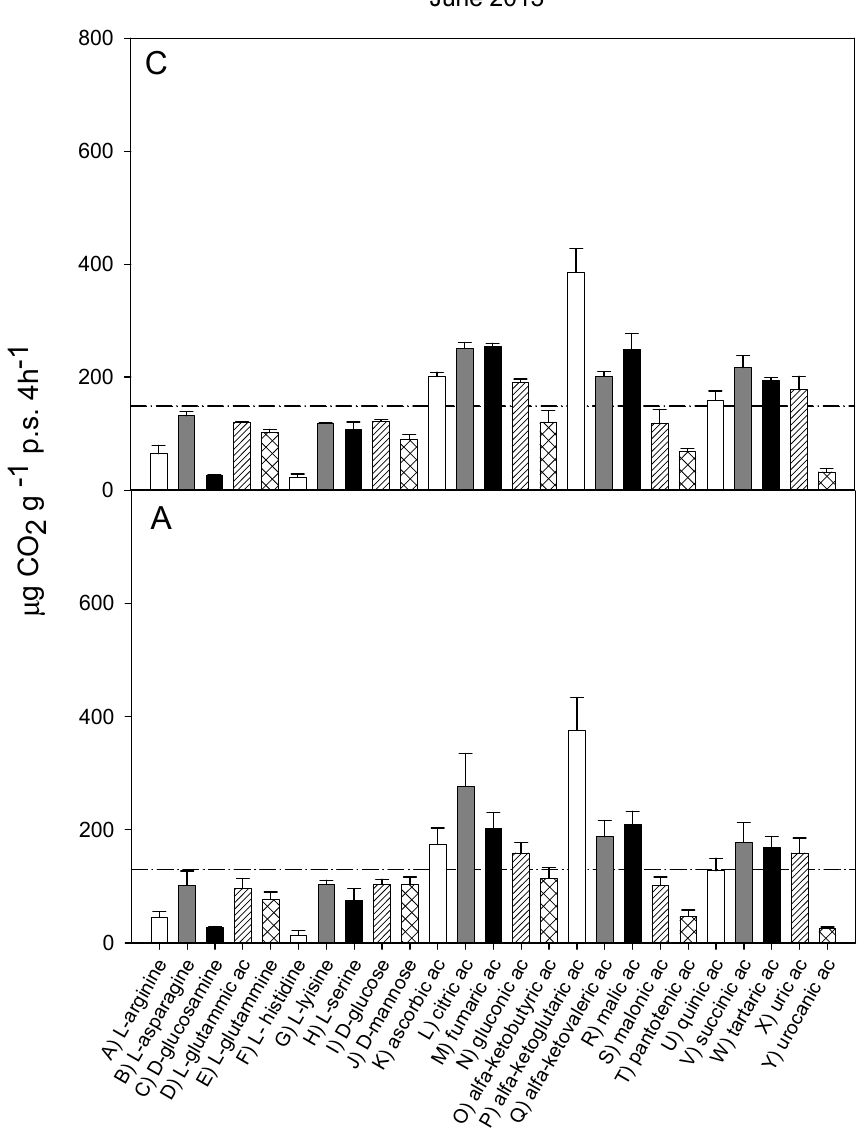
Figure 1. Catabolic response profile of chestnut ( C ) and agricultural ( A ) soils in June 2013. The dotted line represents the average substrate induced respiration (ASIR), corresponding to 149 ± 3.76 in chestnut and to 130 ± 6.7 in agricultural soil (the values were not significantly different).